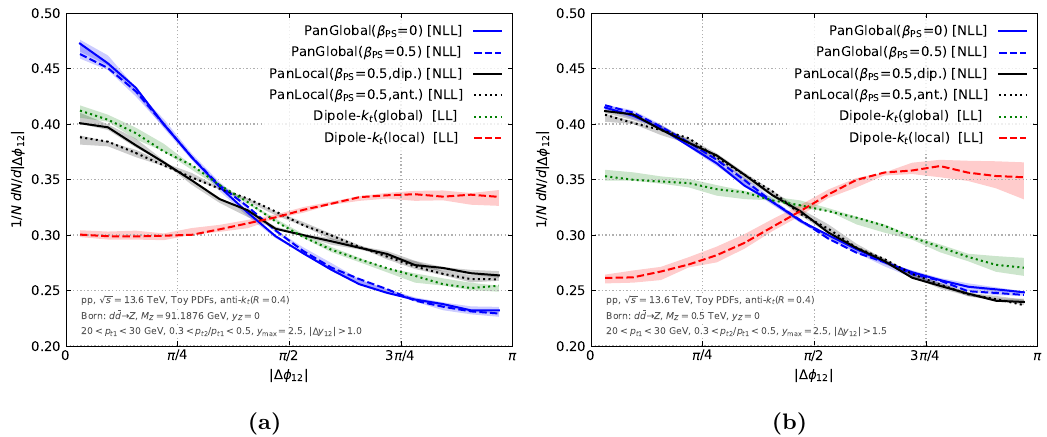
Figure 10. The ∆ φ 12 distribution between the two leading jets, for events that pass the cuts described in the text, (a) for events on the Z pole and a requirement | ∆ y 12 | > 1 . 0 , and (b) for events where the Z is off-shell, with an invariant mass of 500 GeV , and a requirement | ∆ y 12 | > 1 . 5 . The bands correspond to the variation of renormalisation and factorisation scales. Most of the impact of this variation vanishes because the plots are normalised to the number of events that pass the cuts and instead it is the differences between showers within a given logarithmic accuracy class that better provides a measure of residual shower